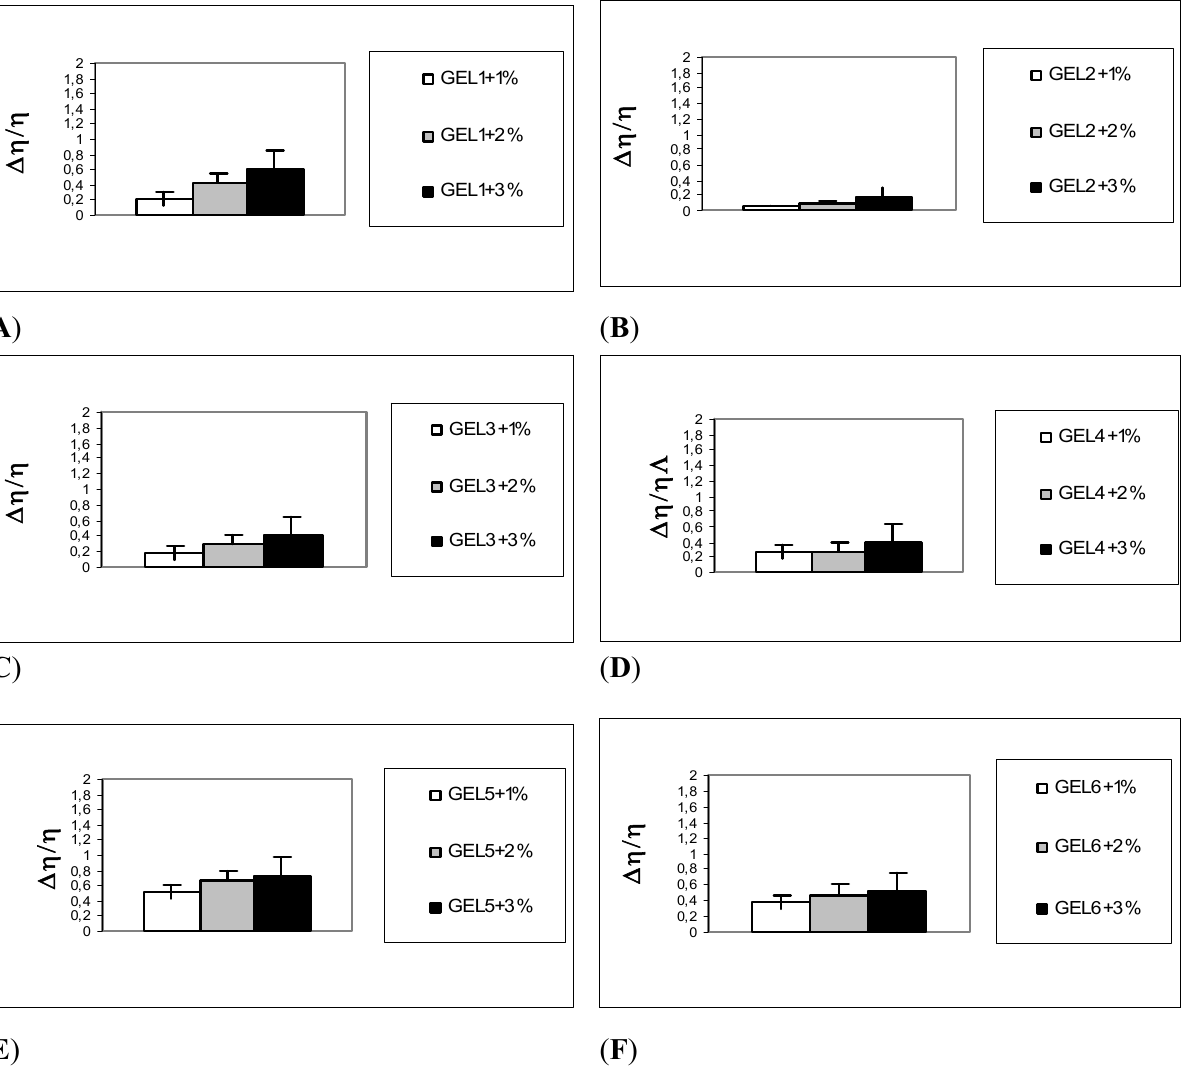
Figure 1. Rheological test with mucin. Gels 1, 4, 5, 6 and 8 contain carboxymethyl cellulose (CMC) in ( A )–( I